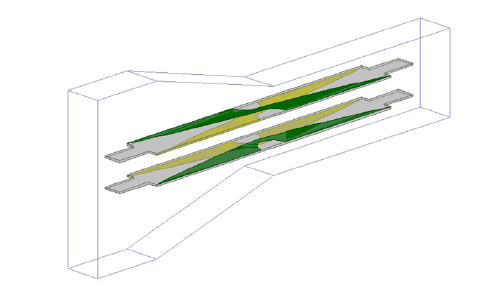
to TE mode transformer. 10 20